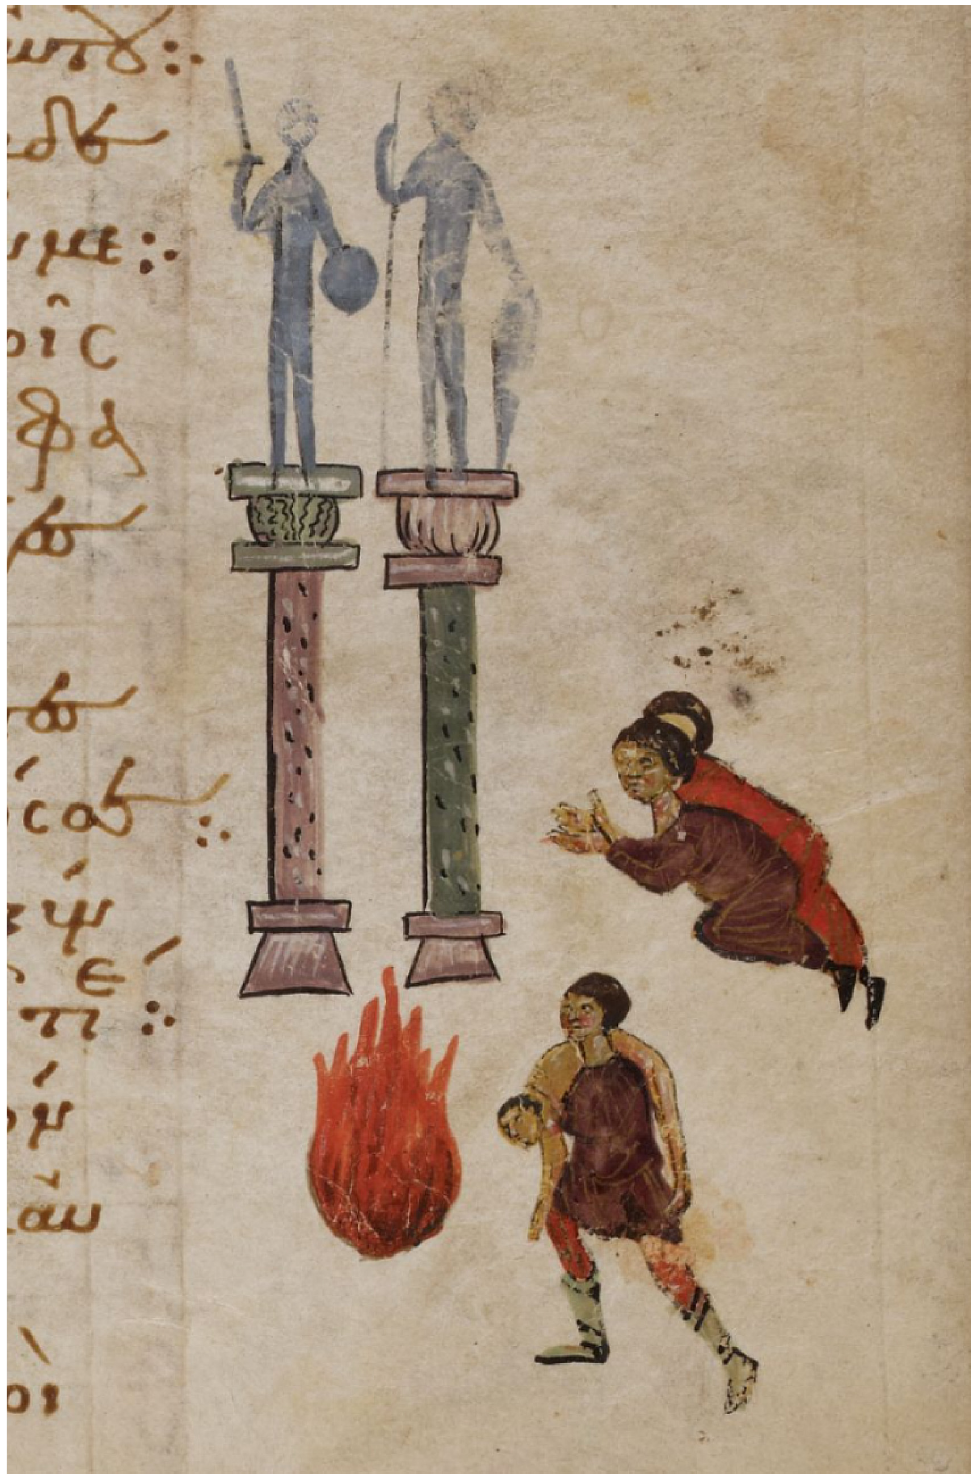
Figure 2. London. British Library. Add MS 19352, fol. 195r (detail). Sacrifices offered to idols. Photo: ©British Library Board, all rights